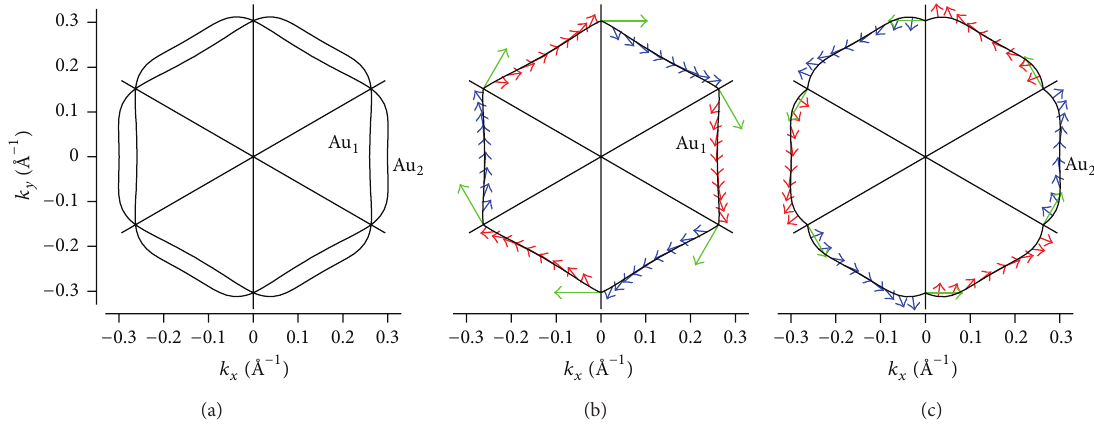
Figure 7: (a) Constant-energy contours at 180 meV above the theoretical Fermi energy for the electron-like bands of Au character. The labels Au 1 and Au 2 correspond to the inner and outer contour, respectively. The same as in Figure 6.